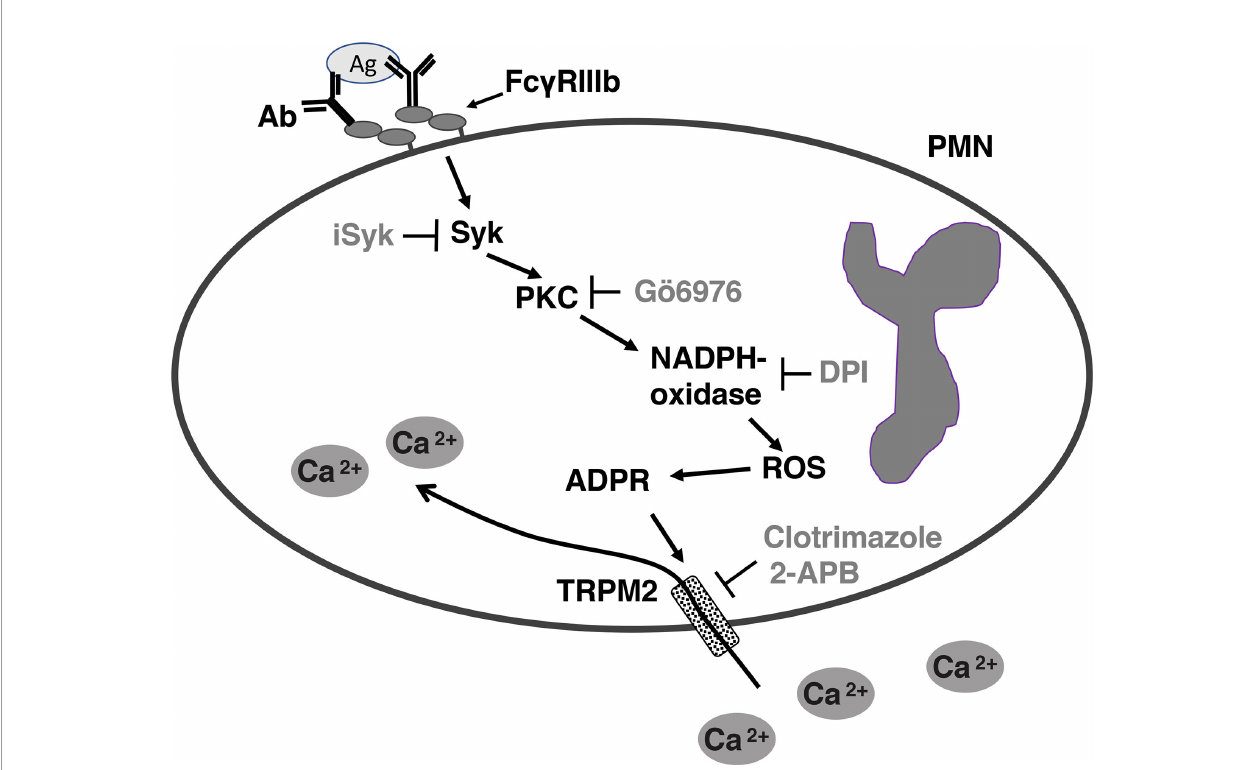
FIGURE 7 | Model for Fc g RIIIb-mediated increase in [Ca 2+ ] i in human neutrophils (PMN). After aggregation of Fc g RIIIb by antibody (Ab)/antigen (Ag) immune complexes, on the plasma membrane of neutrophils (PMN), spleen tyrosine kinase (Syk) gets activated, leading to protein kinase C (PKC) activation. PKC is then required for nicotinamide adenine dinucleotide phosphate oxidase (NADPH-oxidase) activation. NADPH-oxidase, an enzymatic complex assembled on a membrane (not shown), in turn produces reactive oxygen species (ROS), which induce adenosine diphosphate ribose (ADPR) fi nally leading to activation of transient receptor potential melastatin 2 (TRPM2) channels on the plasma membrane. Activated TRMP2 allow in fl ux of extracellular Ca 2+ into the cell. iSyk, an inhibitor of Syk; Gö6976, an inhibitor of PKC; DPI, an inhibitor of NADPH-oxidase; 2-APB, an inhibitor of TRPM2; Clotrimazole, another inhibitor of